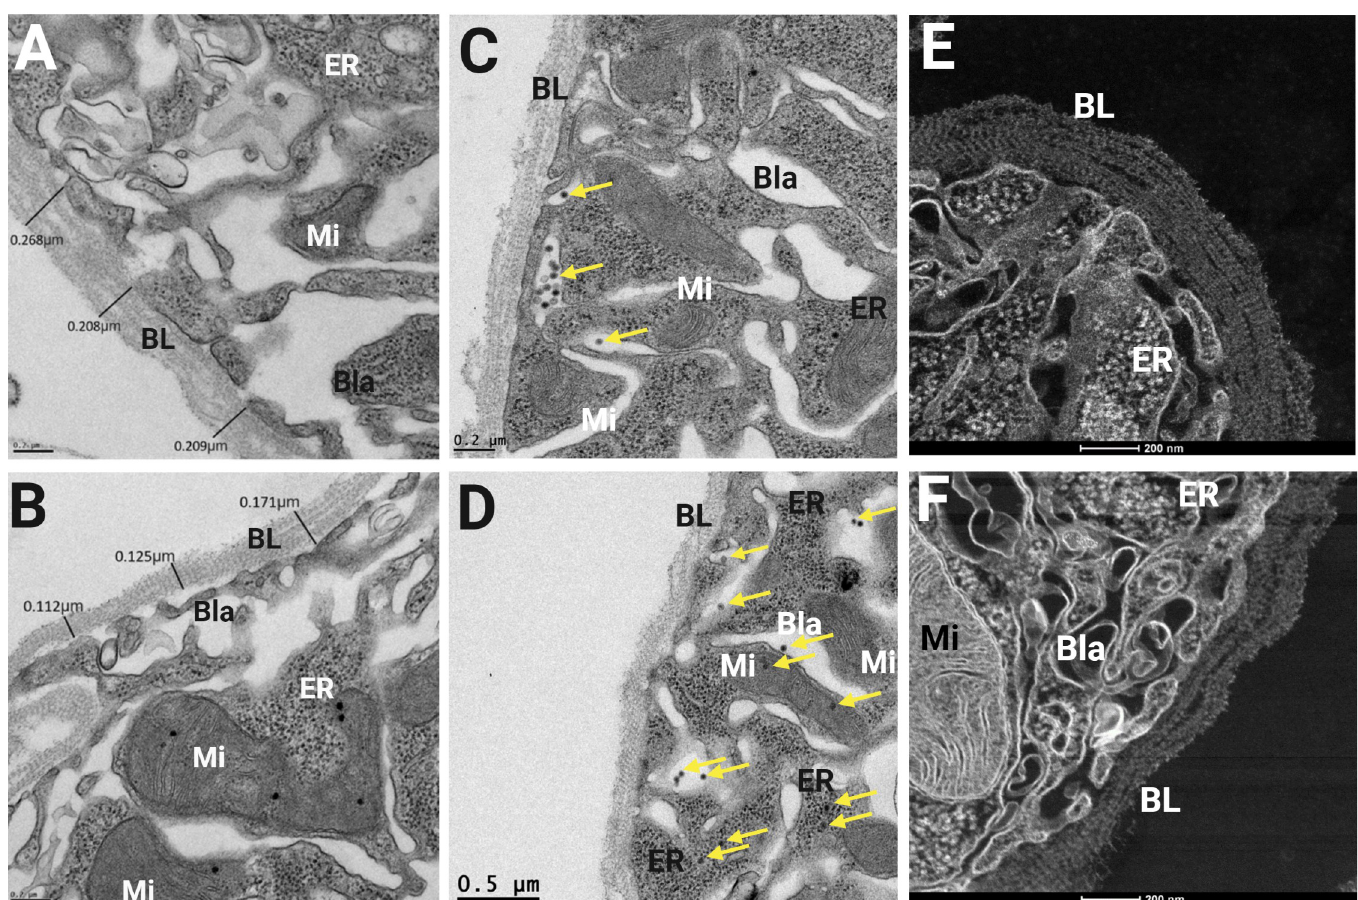
Fig 1. Ultrastructural (TEM) visualization of the midgut BL in Starve and Control Ae . aegypti (HWE). Midguts of Starve and Control Ae . aegypti were dissected at 3 and 5 days post-infection (dpi) via ingestion of a ZIKV-containing blood-meal and visualized by transmission electron microscopy (TEM). TEM images of ( A ) Control and ( B ) Starve midguts are shown with BL width measurements at 5 dpi. ( C ) Multiple virions are accumulating in the basal labyrinth of a Starve midgut at 3 dpi (yellow arrows). ( D ) ZIK virions are shown in a Control midgut both in the basal labyrinth and in the endoplasmic reticulum at 5 dpi. ( E ) Scanning transmission electron microscopy (STEM) images showing a higher number of individual BL strands of a Control midgut at 5 dpi when compared to the ( F ) BL of a Starve midgut. BL = basal lamina, Bla = basal labyrinth, ER = endoplasmic reticulum, Mi = mitochondria. TEM images were captured using a JEOL JEM 1400 transmission electron microscope and STEM images were captured using a ThermoFisher Tecnai F30 Twin 300kV transmission electron microscope/scanning transmission electron microscope.